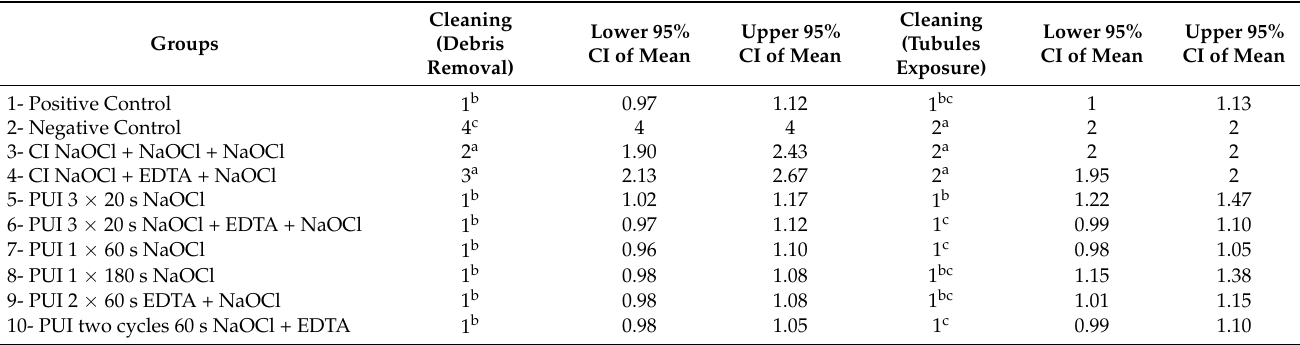
Table 1. Analysis of the general cleaning achieved with each protocol concerning the samples and the dentinal tubules ( p <